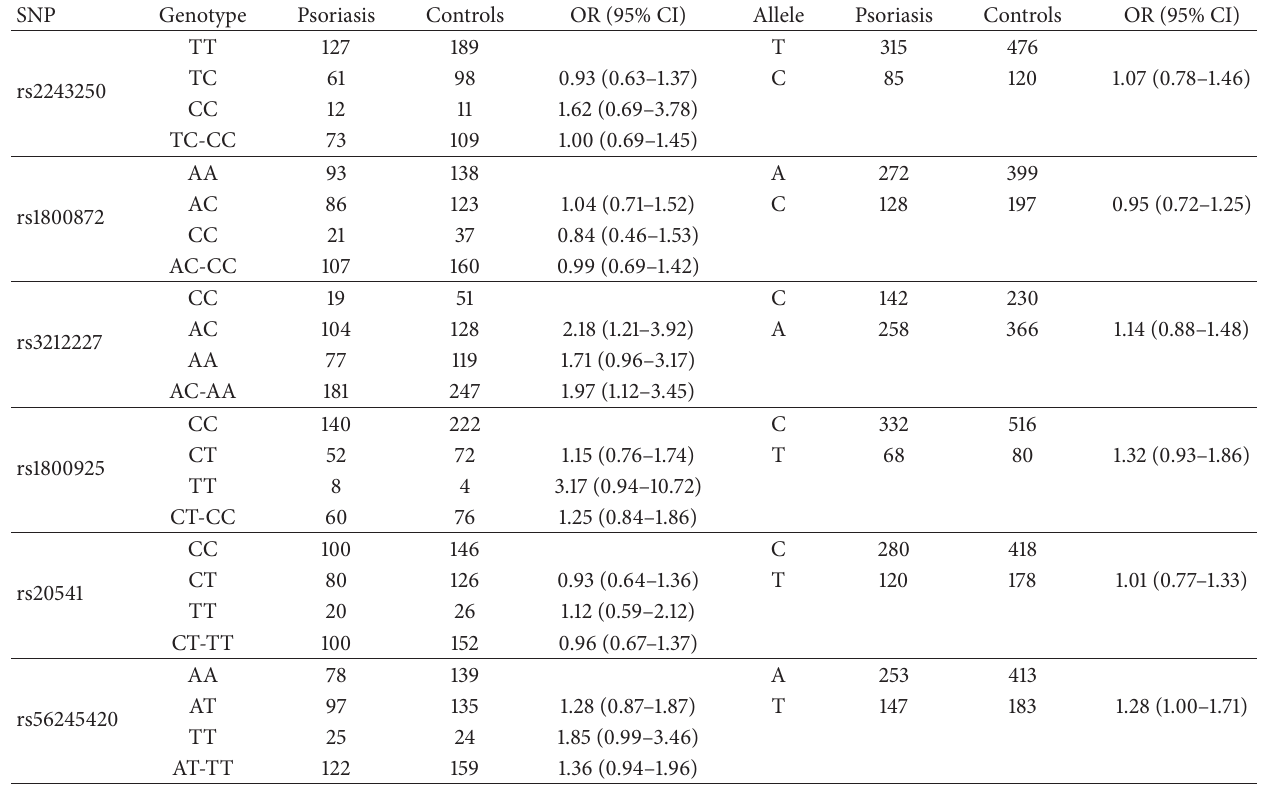
Table 3: Correlation of psoriasis symptoms with SNPs in the IL